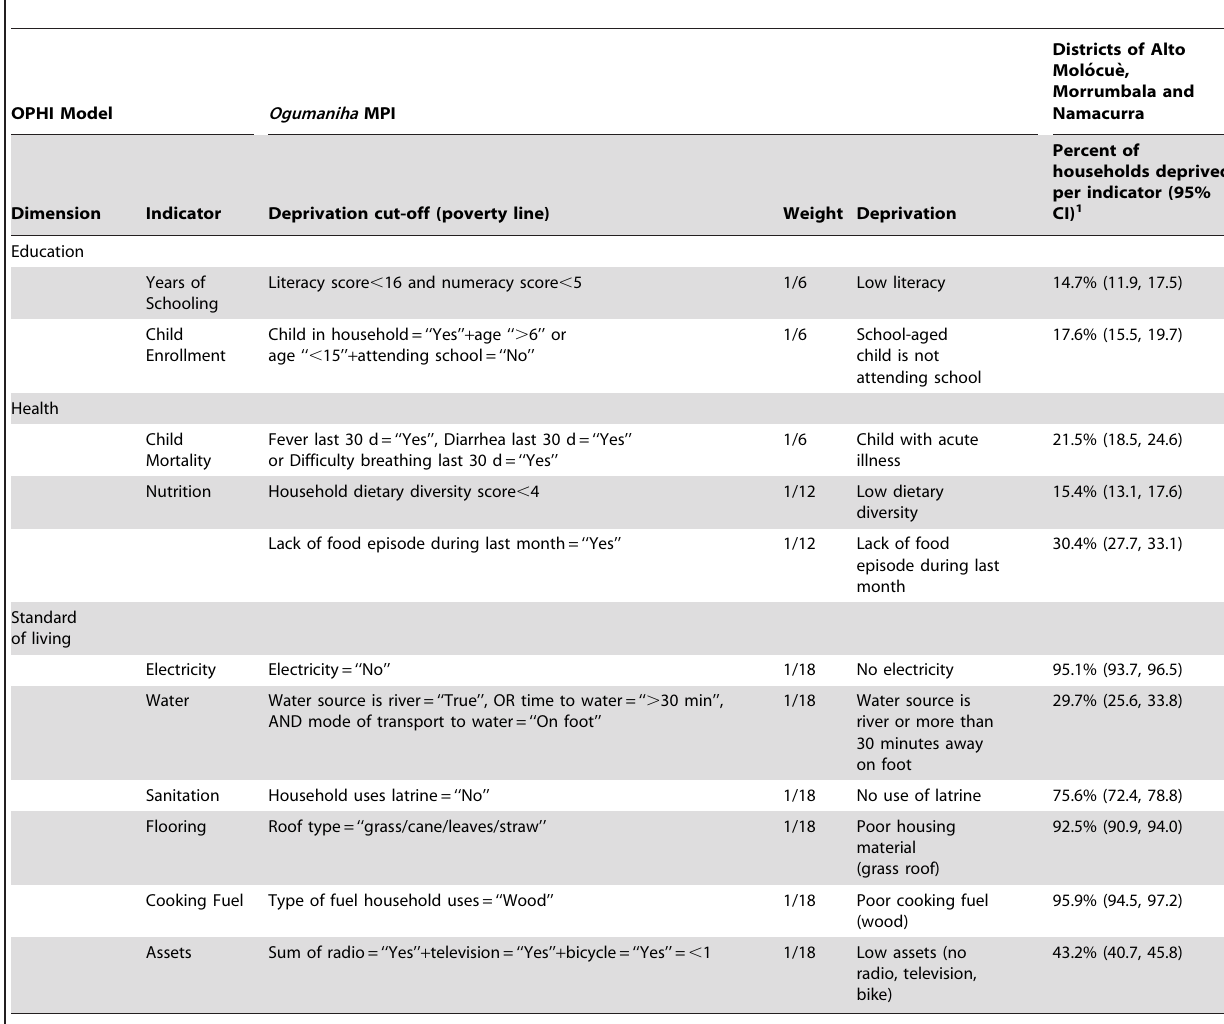
Table 1. Ogumaniha Multidimensional Poverty Index (MPI) adapted from the Oxford Poverty and Human Development Initiative (OPHI).